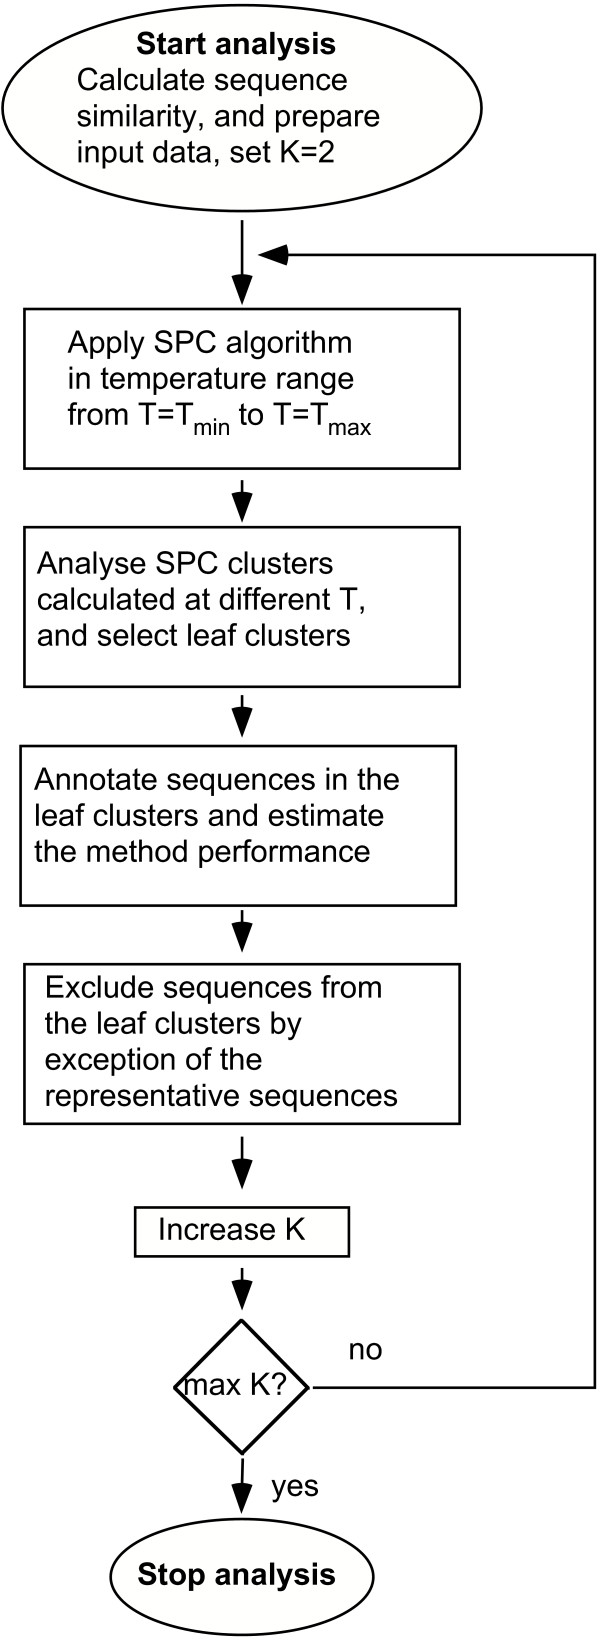
Data-flow of the gSPC algorithm.